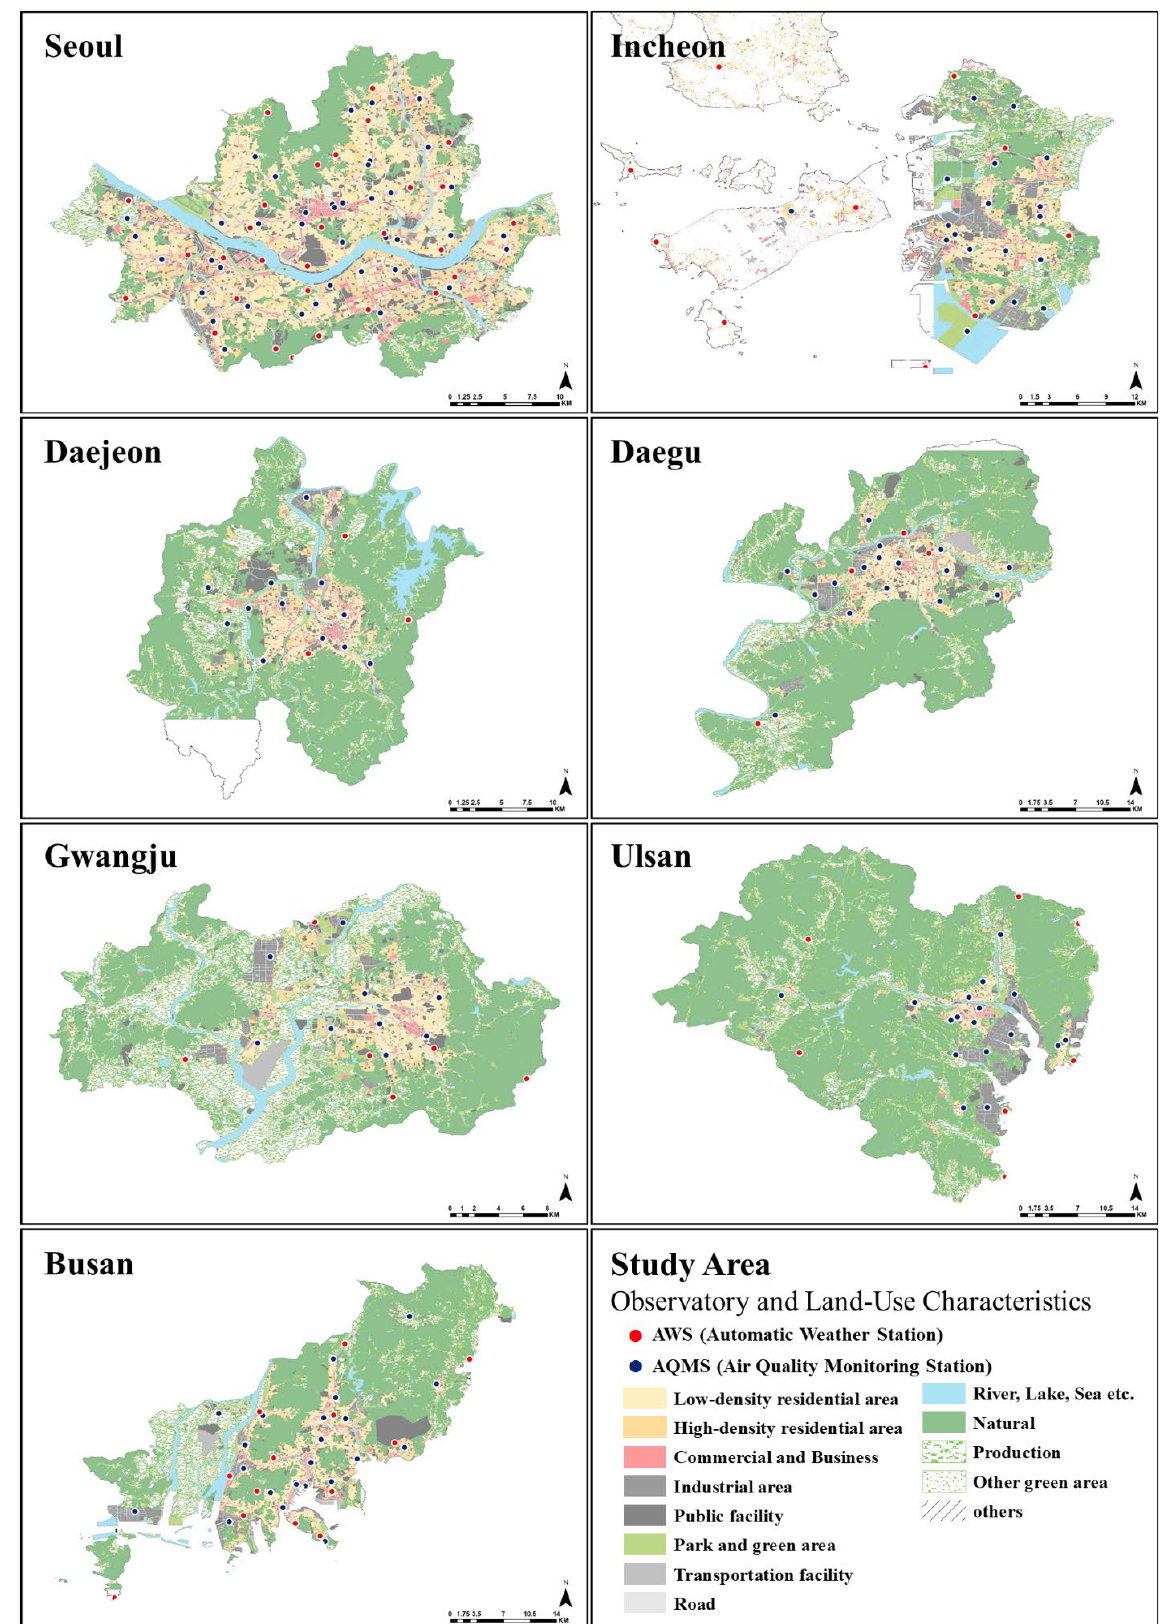
Figure 2. Observatory and Land-use Characteristics in seven metropolitan cities.